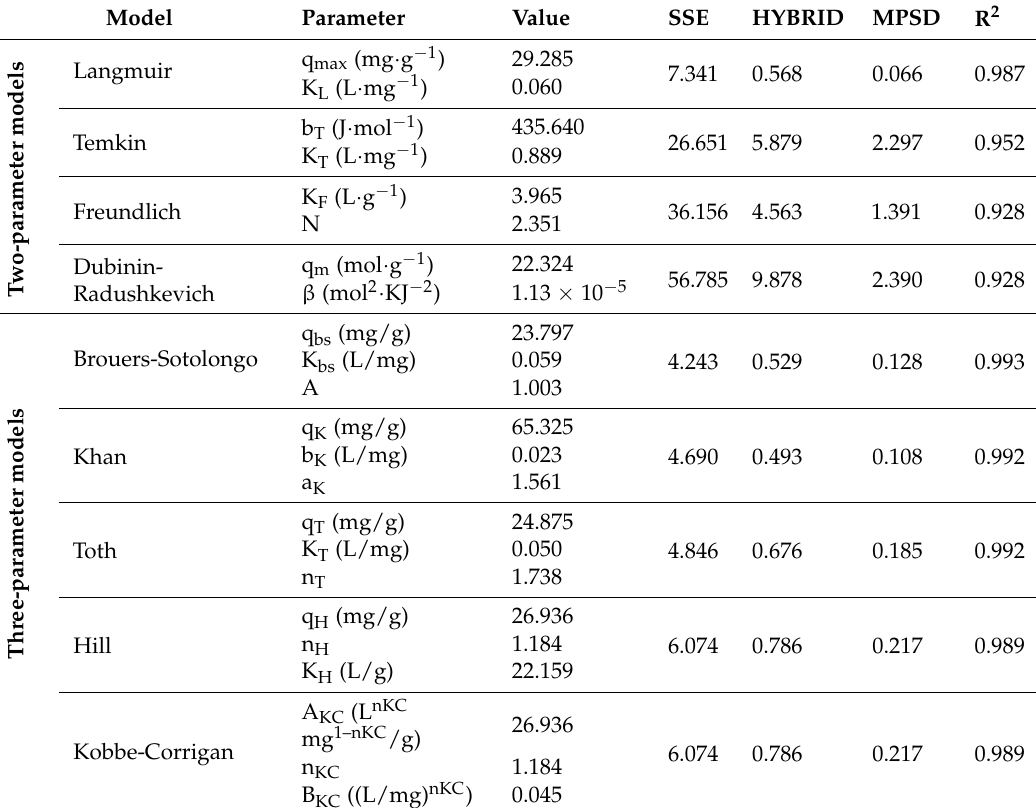
Table 7. Copper adsorption onto olive pomace at equilibrium and their fitting by two-parameter and three-parameter models.